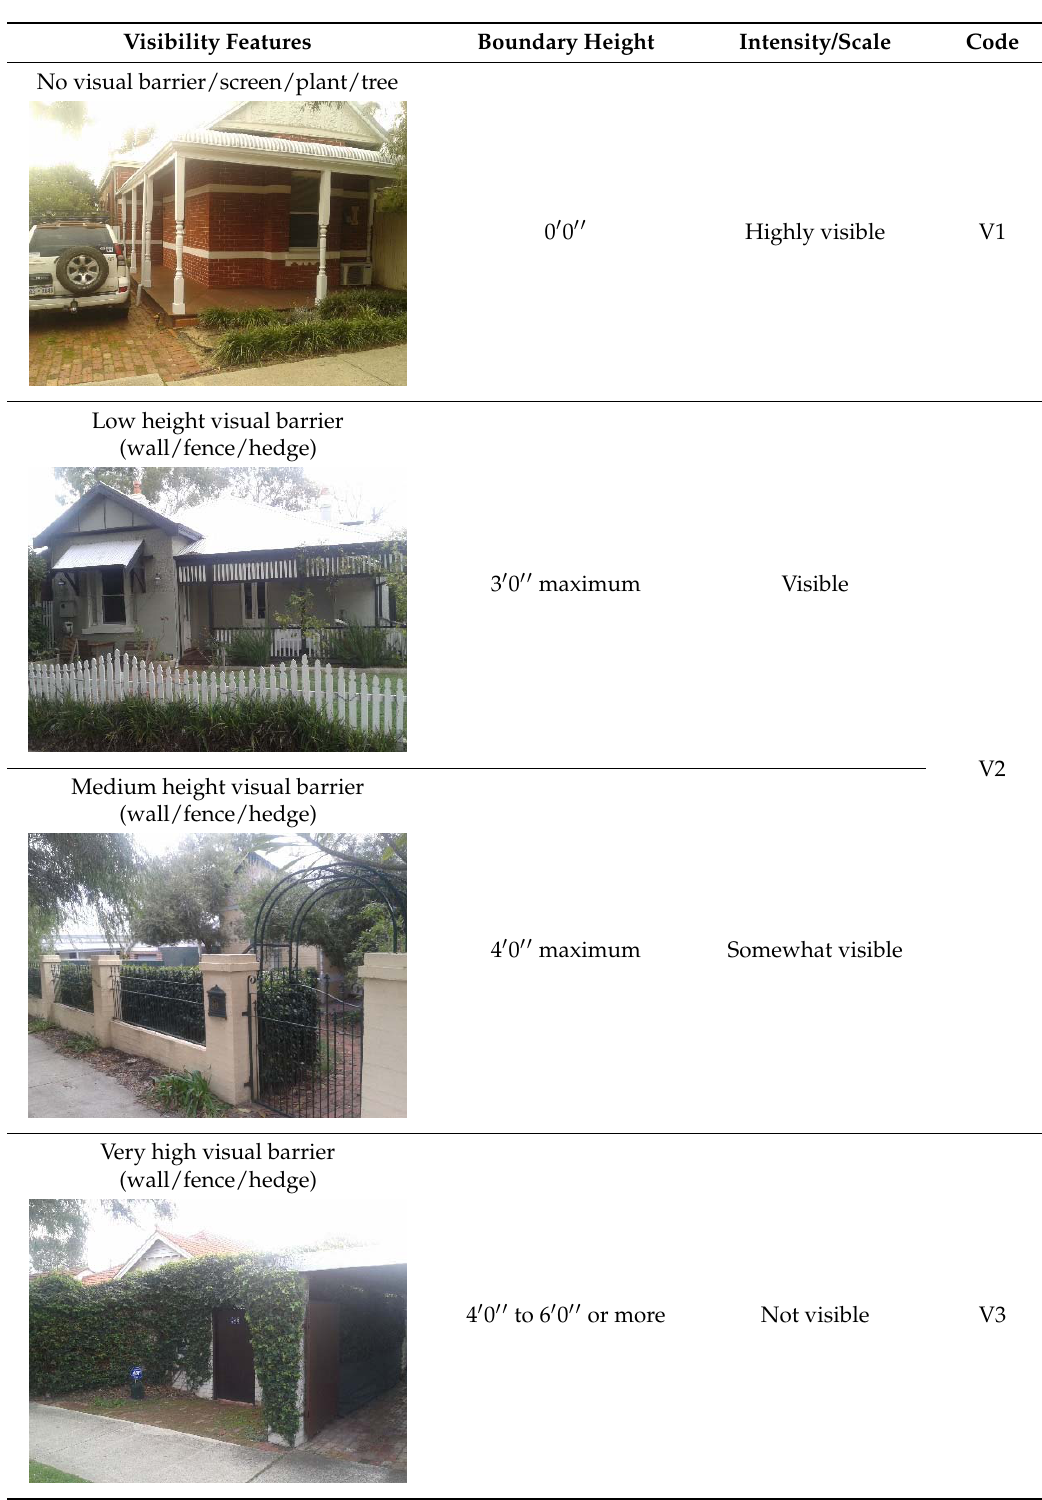
Table 3. Types of visual permeability.